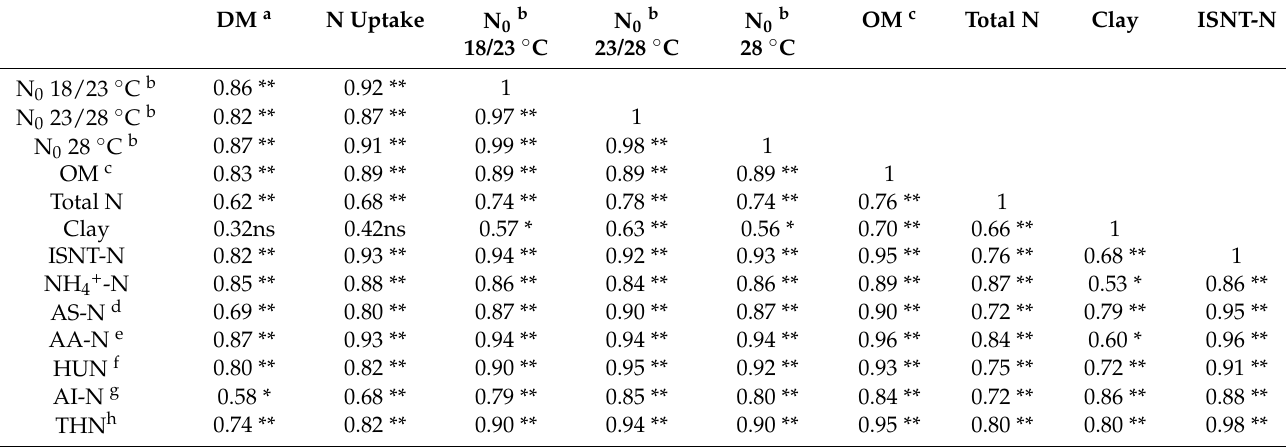
Table 6. Correlations among maize growth and N uptake, soil properties, potentially mineralizable N estimated by incubation (N 0 ) or the Illinois Soil Nitrogen Test (ISNT), and hydrolysable soil N fractions.